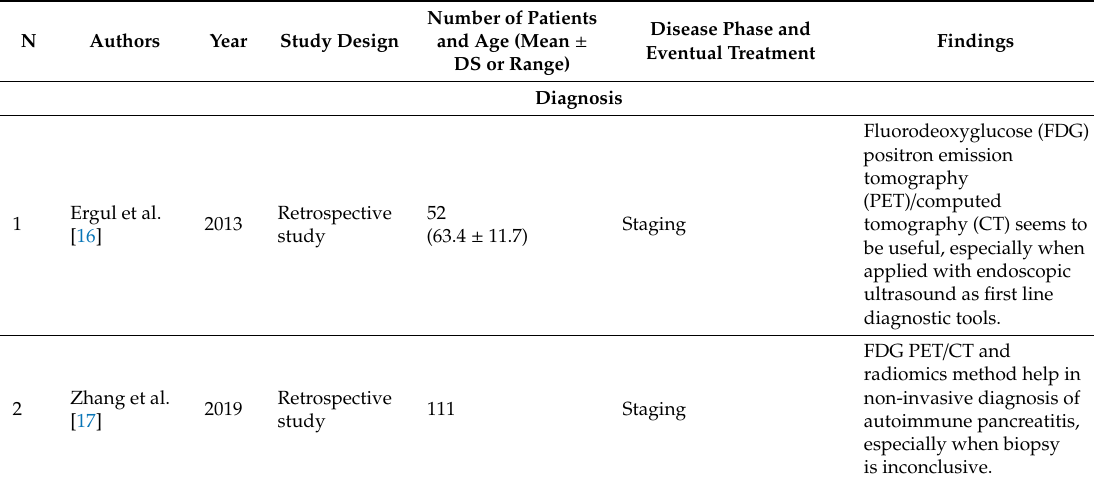
Figure 1. Preferred Reporting Items for Systematic reviews and Meta-Analyses (PRISMA) flow-chart. Selection process of studies included in the qualitative and quantitative analysis according to the PRISMA flow diagram [14]. Table 1. Main findings and summary of articles